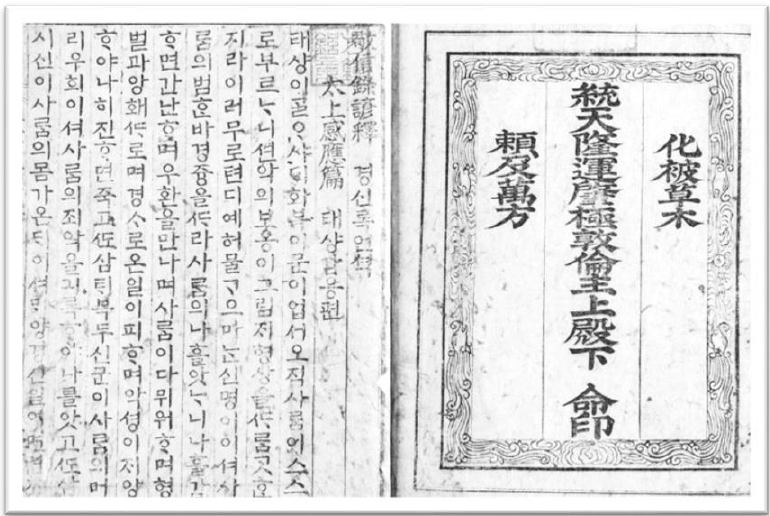
Figure 10. Sprit-Written Inscription in Morality Books (Kyujang-gak Library) Printed by Royal Edict in 1880 (Collection of Kojong’s Library).